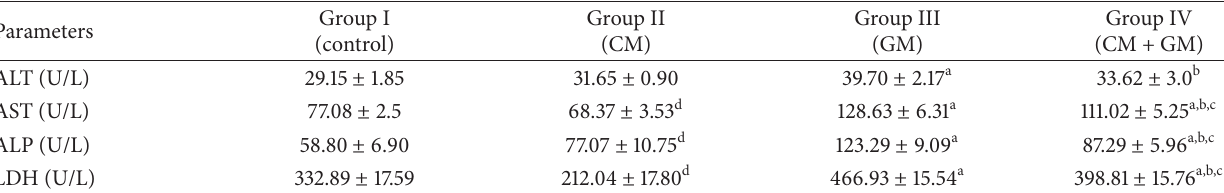
Table 1: Effect of camel milk on the activity of alanine aminotransferase (ALT), aspartate aminotransferase (AST), alkaline phosphate (ALP), and lactate dehydrogenase (LDH).